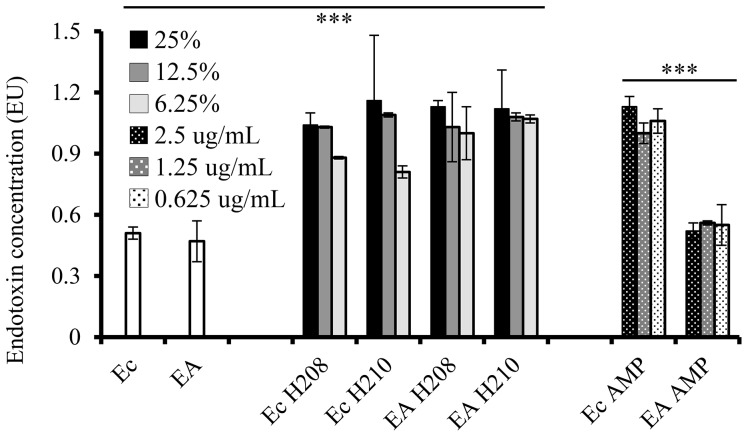
Endotoxin release from ampicillin-sensitive and ampicillin-resistant E. coli cells after exposure to different concentrations of honey and ampicillin.(EA: ampicillin-resistant E. col, Ec-E. coli). The bars represent the mean ± standard deviation (n = 4). See text for statistical results. *** - p<0.0001.